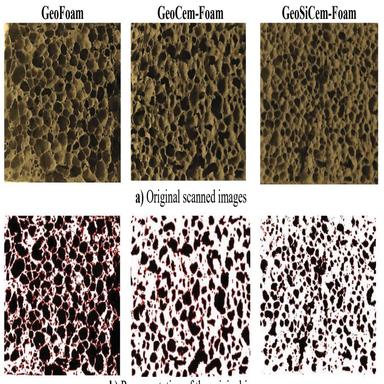
Digital processing of the scanned geopolymer foam plates: a) Original scanned image of the saw-cut flat surface of a sample; b) Representation of the original images with black representing the voids, white the flat material matrix and red the extracted void boundaries. (For interpretation of the references to color in this figure legend, the reader is referred to the web version of this article.)